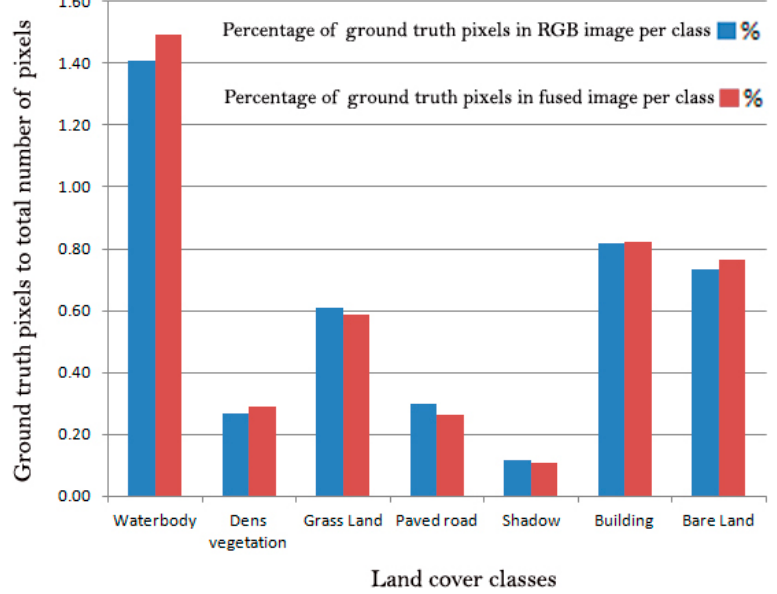
Figure 4. Percentage and distribution of all GT to total classified pixels for each land cover class.